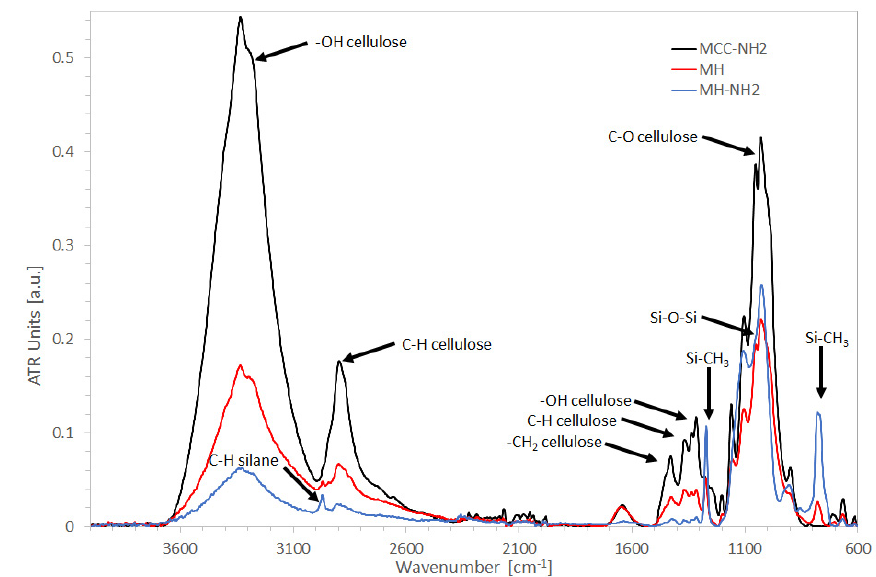
Fig. 9 The FT-IR spectra of MCCH, MH and MH-NH